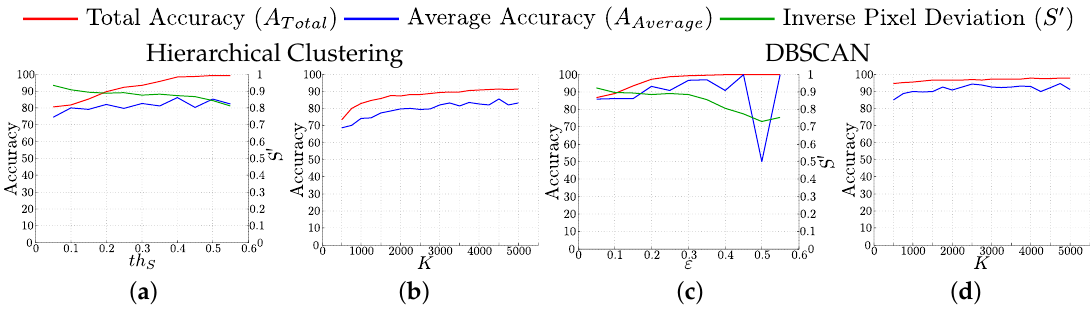
Figure 6. Influence of parameters, th S , ε and K in the performance of the vocabulary. We show the evolution of total ( red ) and average ( blue ) accuracy and normalized inverse pixel deviation ( green ) for th S ( a ) and ε ( c ) with K = 3000 and for K ; ( b ) and ( d ), for th S and ε equal to